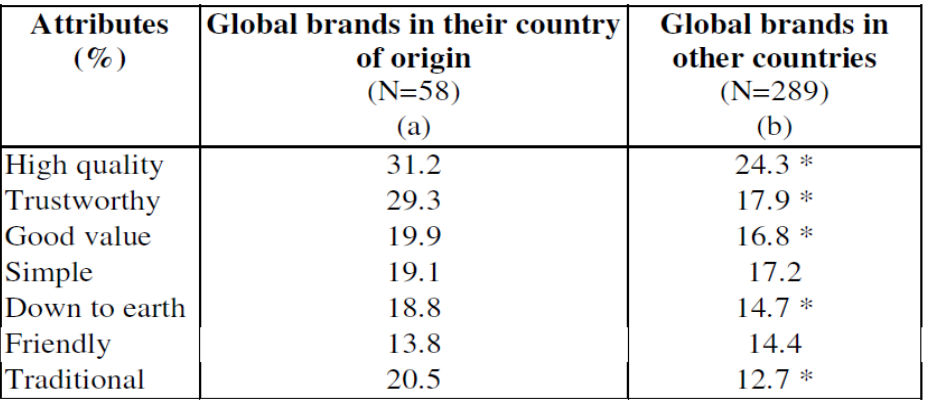
Table 1: Image Attributes of Global